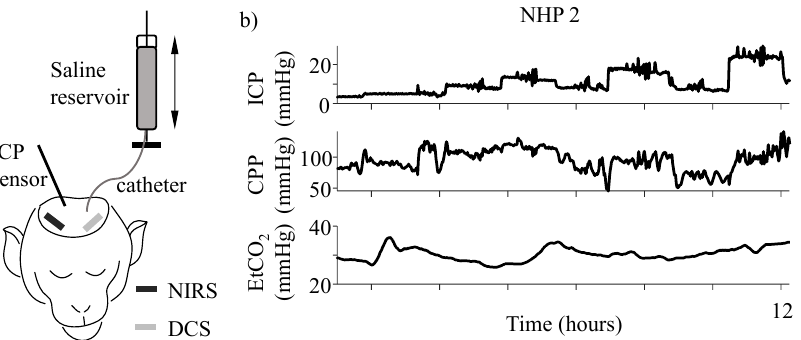
Figure 1. Experimental setup. ( a ) Schematic representation of the experimental setup. Black and gray bars at the frontal locations show the NIRS and DCS locations, respectively. ICP was measured using an invasive parenchymal pressure sensor and altered by changing the position of the saline reservoir connected to an intraventricular catheter. ( b ) Time traces of different experimental variables. The top panel shows the induced changes in ICP, the middle panel shows the calculated CPP (=MAP-ICP). The bottom panel shows a time trace of the recorded EtCO 2 for the duration of the